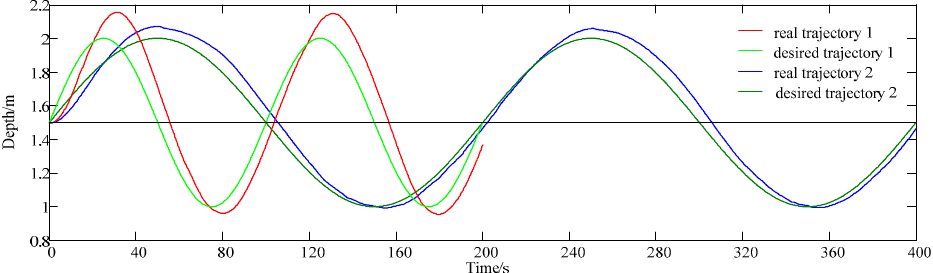
Figure 5. Experimental result of tracking the sinusoidal trajectory with periods of 100 s and 200 s. The period of trajectory 1 is 100 s and the period of trajectory 2 is 200 s.